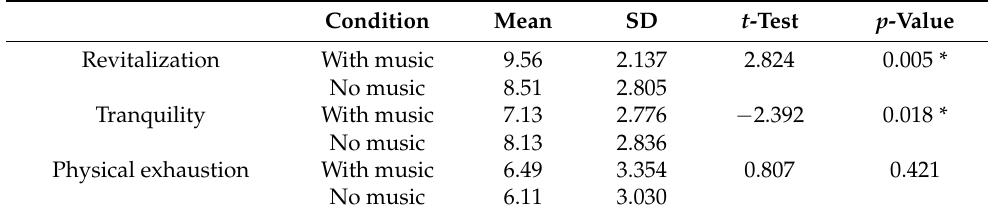
Table 5. Table with and without music for EFI